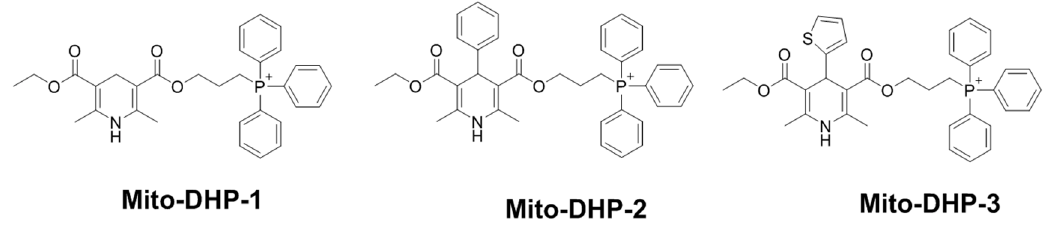
Figure 5. Representative targeted compounds.